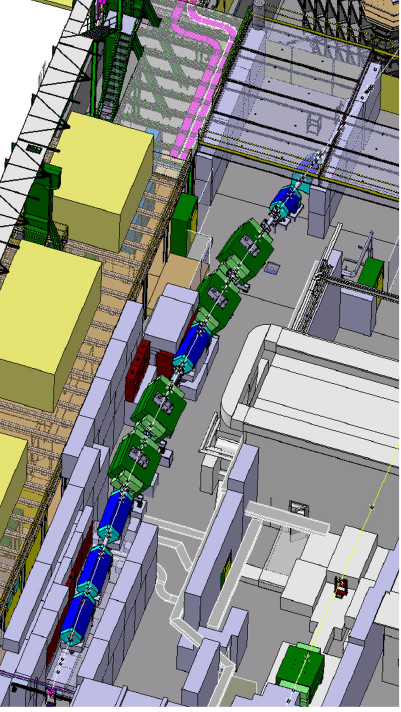
FIG. 5. 3D model layout of the H2-VLE beam line. The quadrupole triplet (in blue) and the target in front of it, are shown in the left of the picture. Part of the NP-02 cryostat is shown in the right of the picture. (Courtesy: V. Clerc and S. Girod)